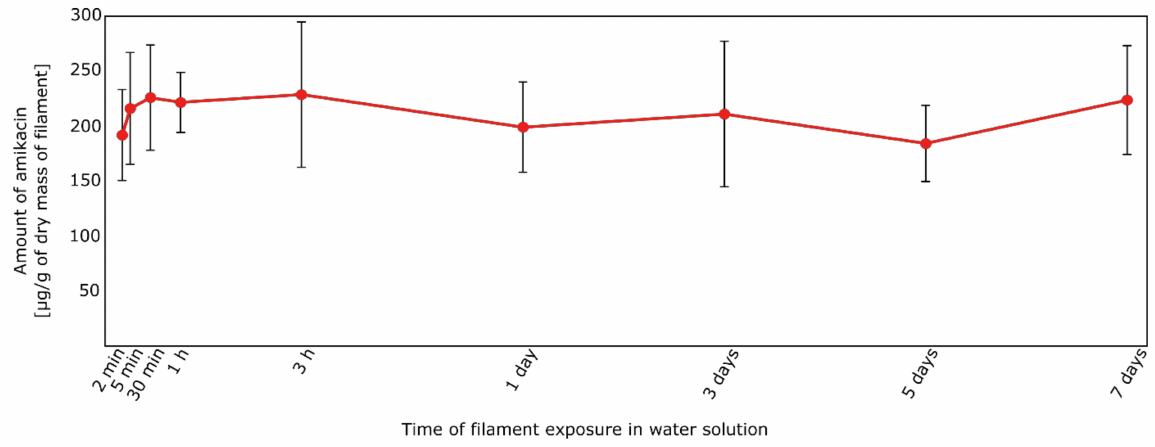
Figure 15. Amount of amikacin [ µ g/g of dry mass of filament] released from the AMI-1 filaments.